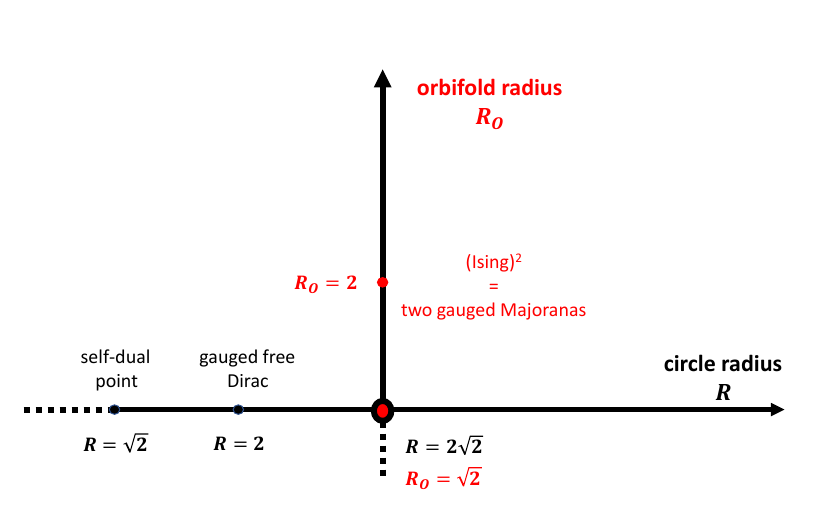
Figure 1: The moduli space of bosonic c = 1 CFTs with marginal